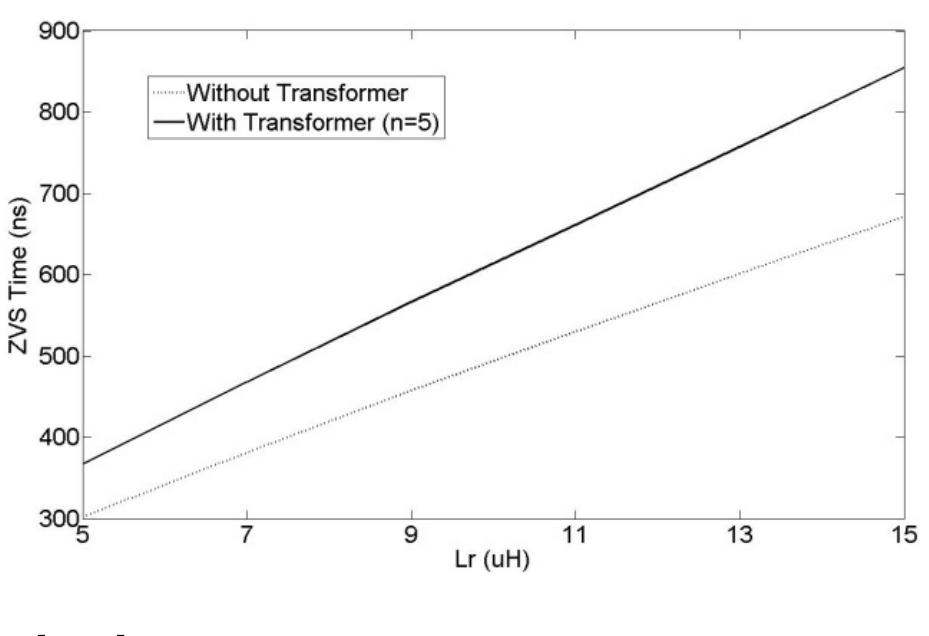
Figure 10. Graph of characteristic curves of ZVS time values vs. L r for different values of n with C = 50 nF and C s = 3 r